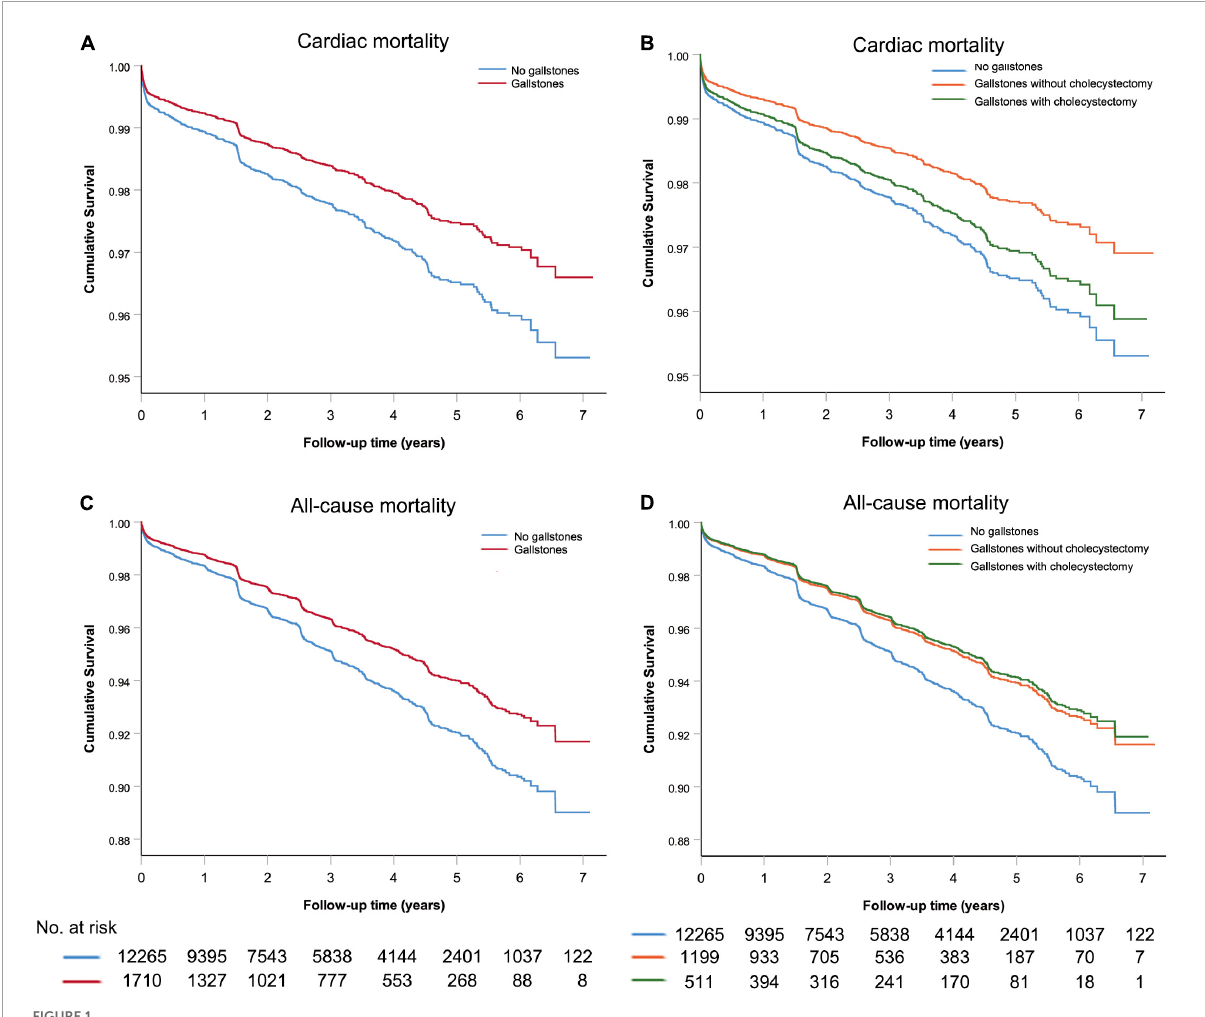
FIGURE1 The cumulative survival analysis for acute coronary syndrome patients with or without gallstone (A,C) and subgroup analysis for gallstone patients with or without cholecystectomy (B,D)